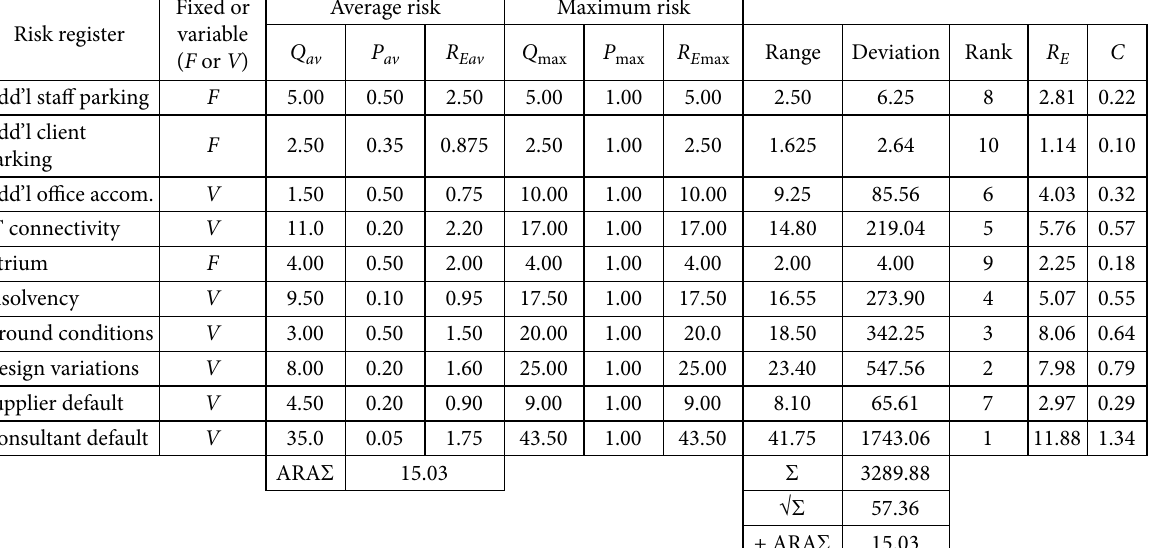
Table 1. Exemplar Data for MERA calculation and phase portrait